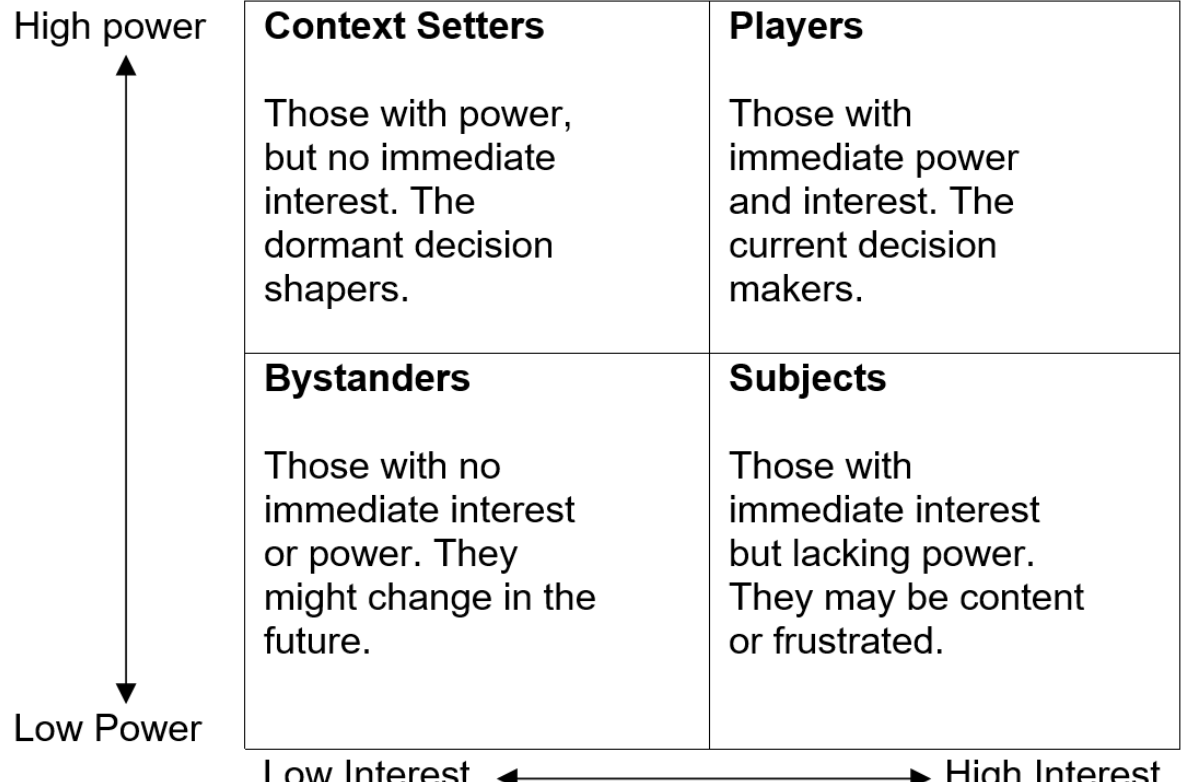
Figure 1. Stakeholder power-interest matrix (based on Wright & Cairns,